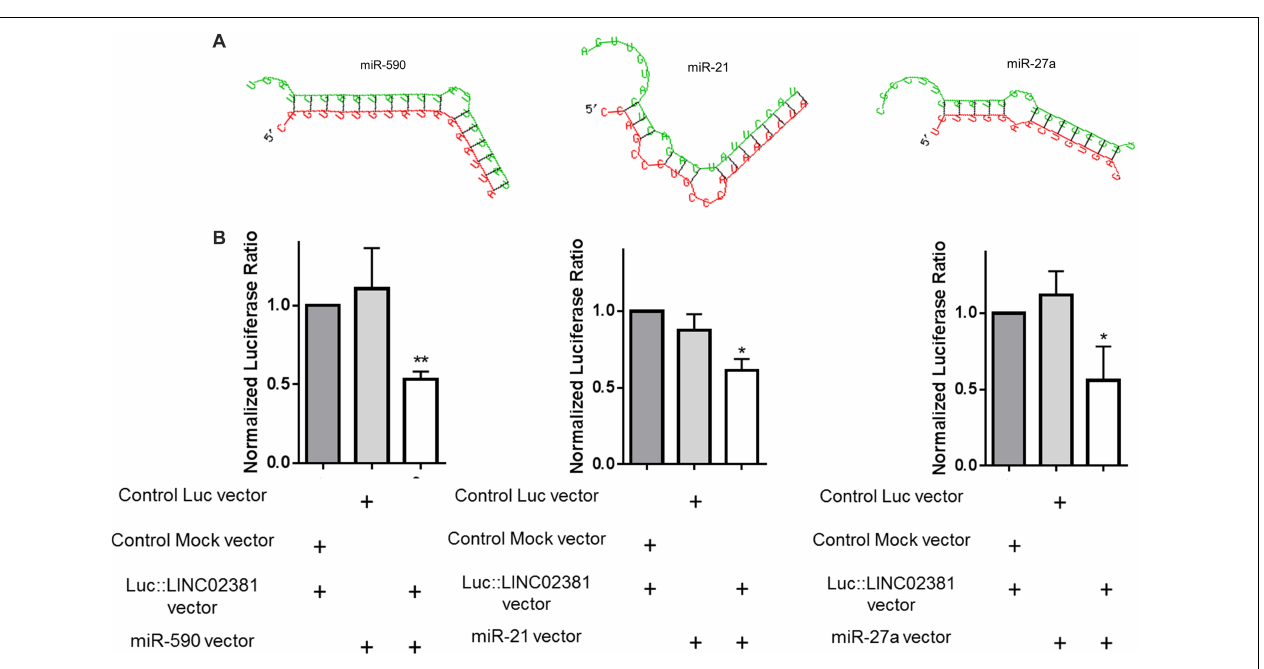
FIGURE 3 | Evidence for the interaction of LINC02381 with miR-590, miR-21, and miR-27a. (A) Shows strong alignment status of miR-590, miR-21, and miR-27a sequences with LINC02381 sequence. (B) Shows dual luciferase assays results of LINC02381 interaction with candidate miRNAs. All tested miRNAs seem to interact with LINC02381 sequence that is cloned downstream to luciferase coding region. Data represent the mean ± SEM from three independent experiments. * P < 0.05, ** P <